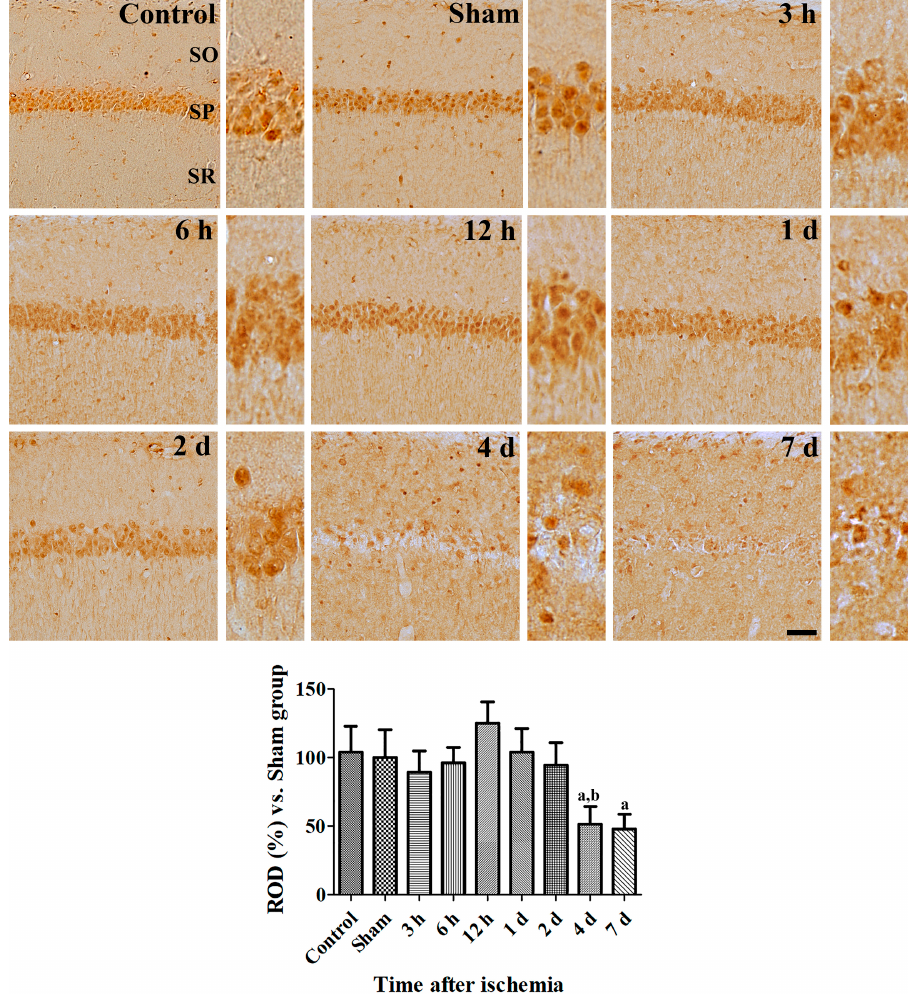
Figure 3. Spatial and temporal changes of CRIP1a immunoreactivity in the gerbils at various time points after ischemia. Relative optical densities in each region are described as a percentage of the value of the sham group, and a one-way ANOVA test was used to analyze the data followed by Bonferroni’s post-hoc test ( n = 5 per group; a p < 0.05, significantly different from the Sham group; b p < 0.05, significantly different from the pre-adjacent group). SO, stratum oriens; SP, stratum pyramidale; SR, stratum radiatum.